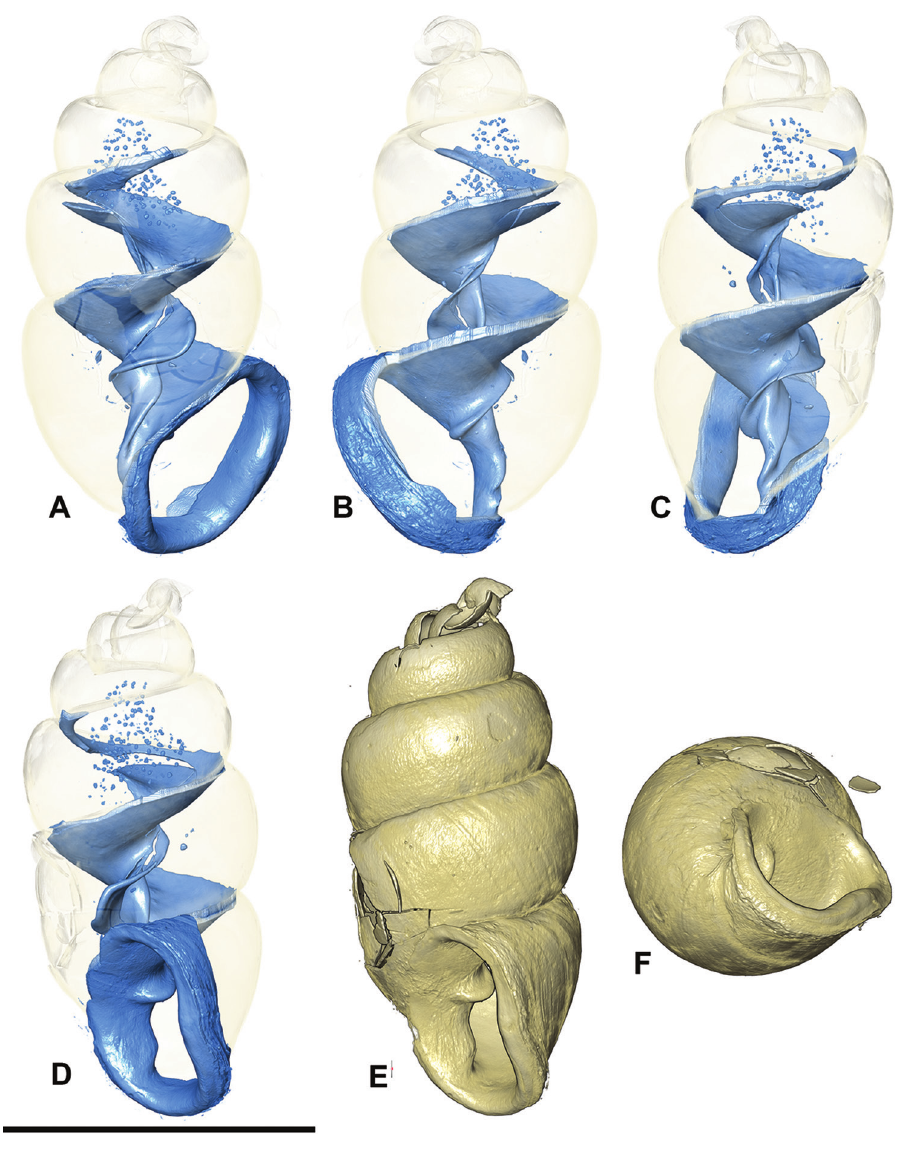
Figure 14. Carychium zarzaae sp. n. A–D CT scans showing columellar apparatus of paratype (NMBE 549927/1) D–F prominent parietal denticle. Scale bar 1